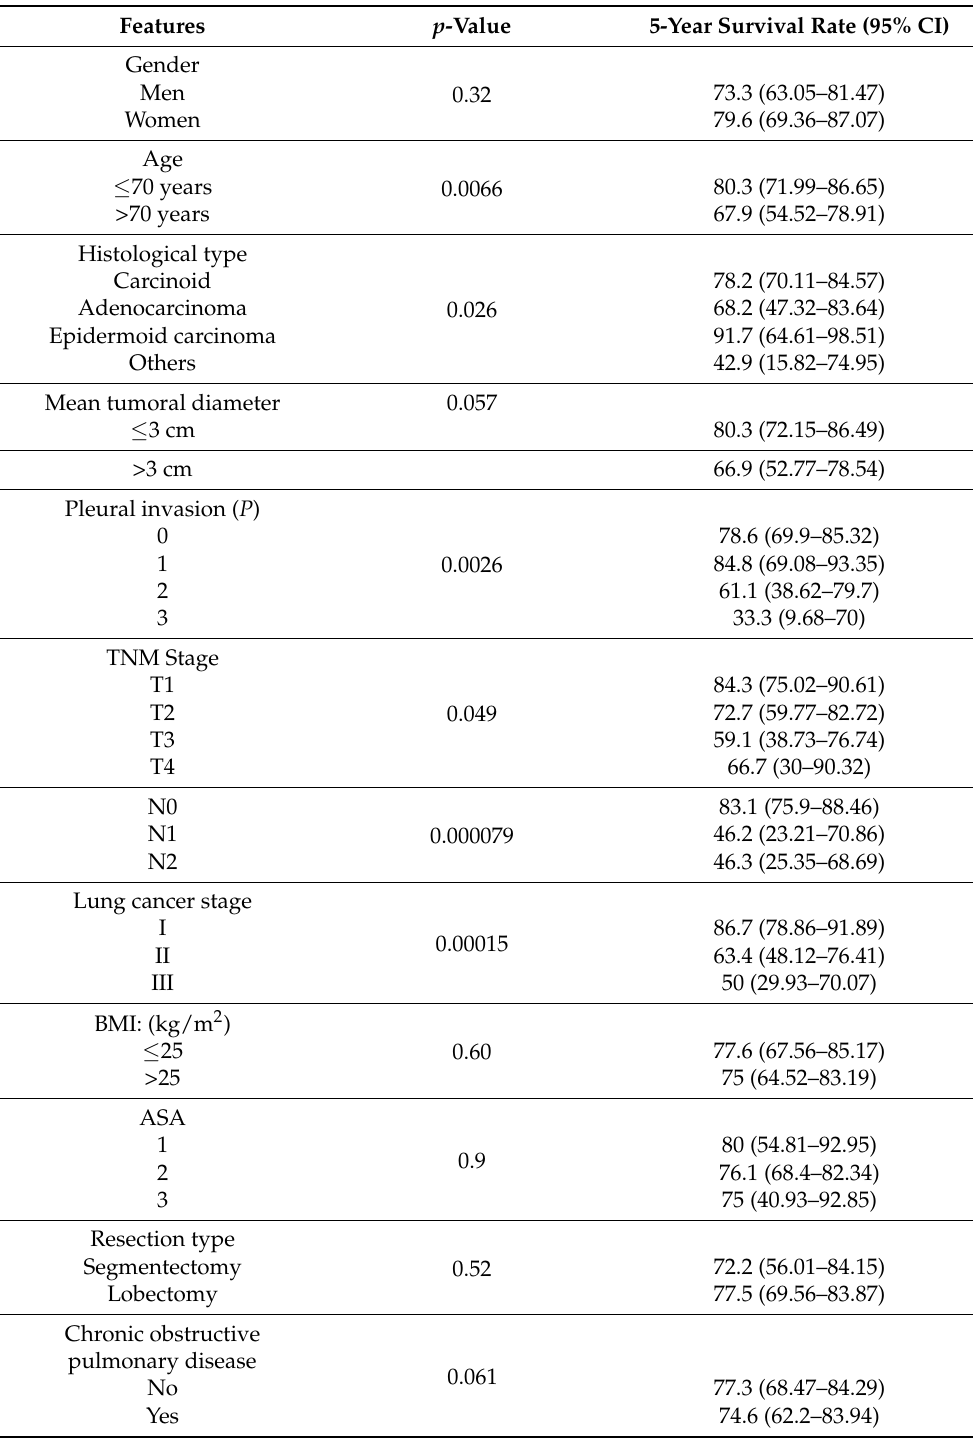
Table 4. Long term survival (first period): Univariable analysis. ASA: American Society of Anesthesi- ologists classification of physical status. COPD: Chronic Obstructive Pulmonary Disease. 95% CI: 95% Confidence